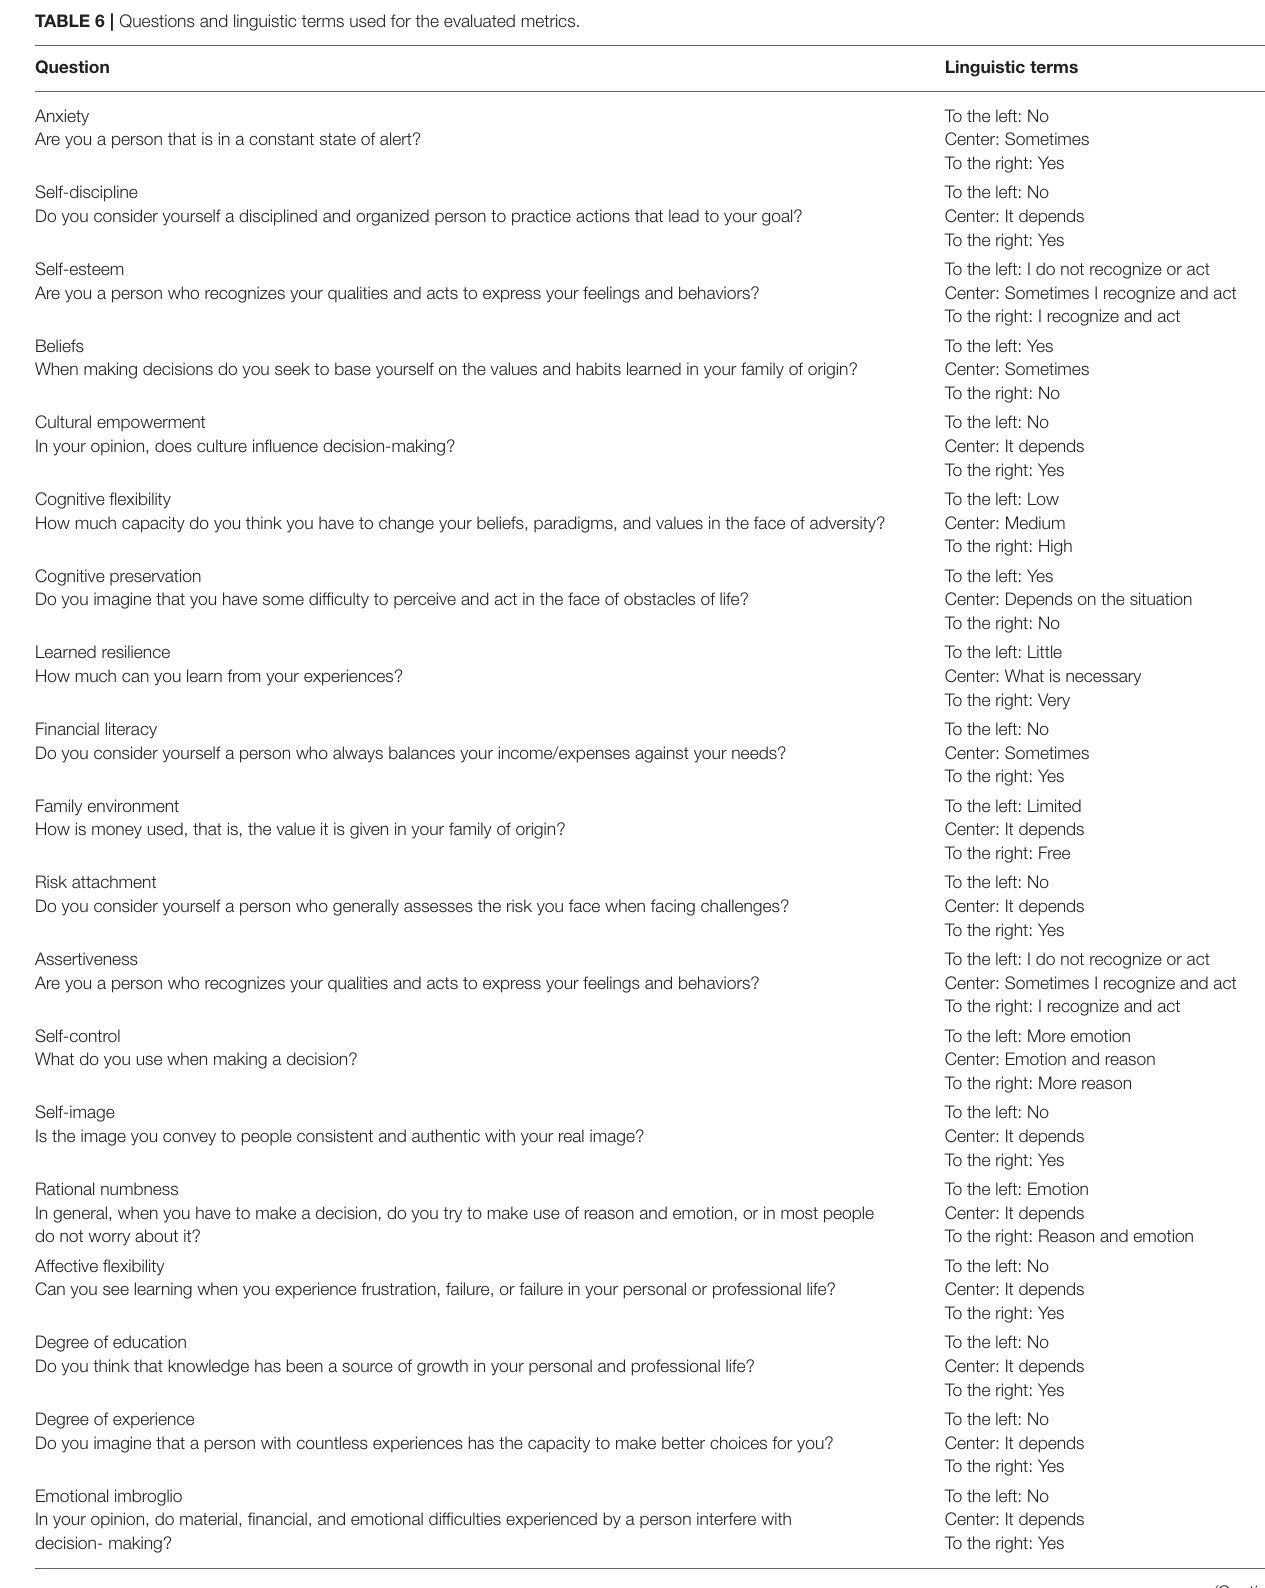
TABLE 6 | Questions and linguistic terms used for the evaluated metrics. Question Linguistic